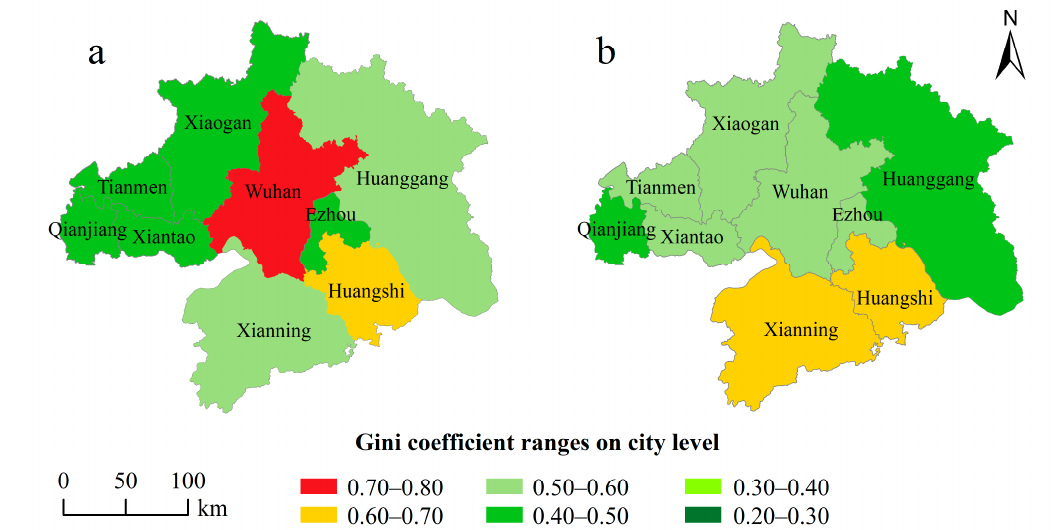
Figure 9. Gini coefficient on city level based on both methods: ( a ) results of this study; ( b ) results of not considering the population factor.